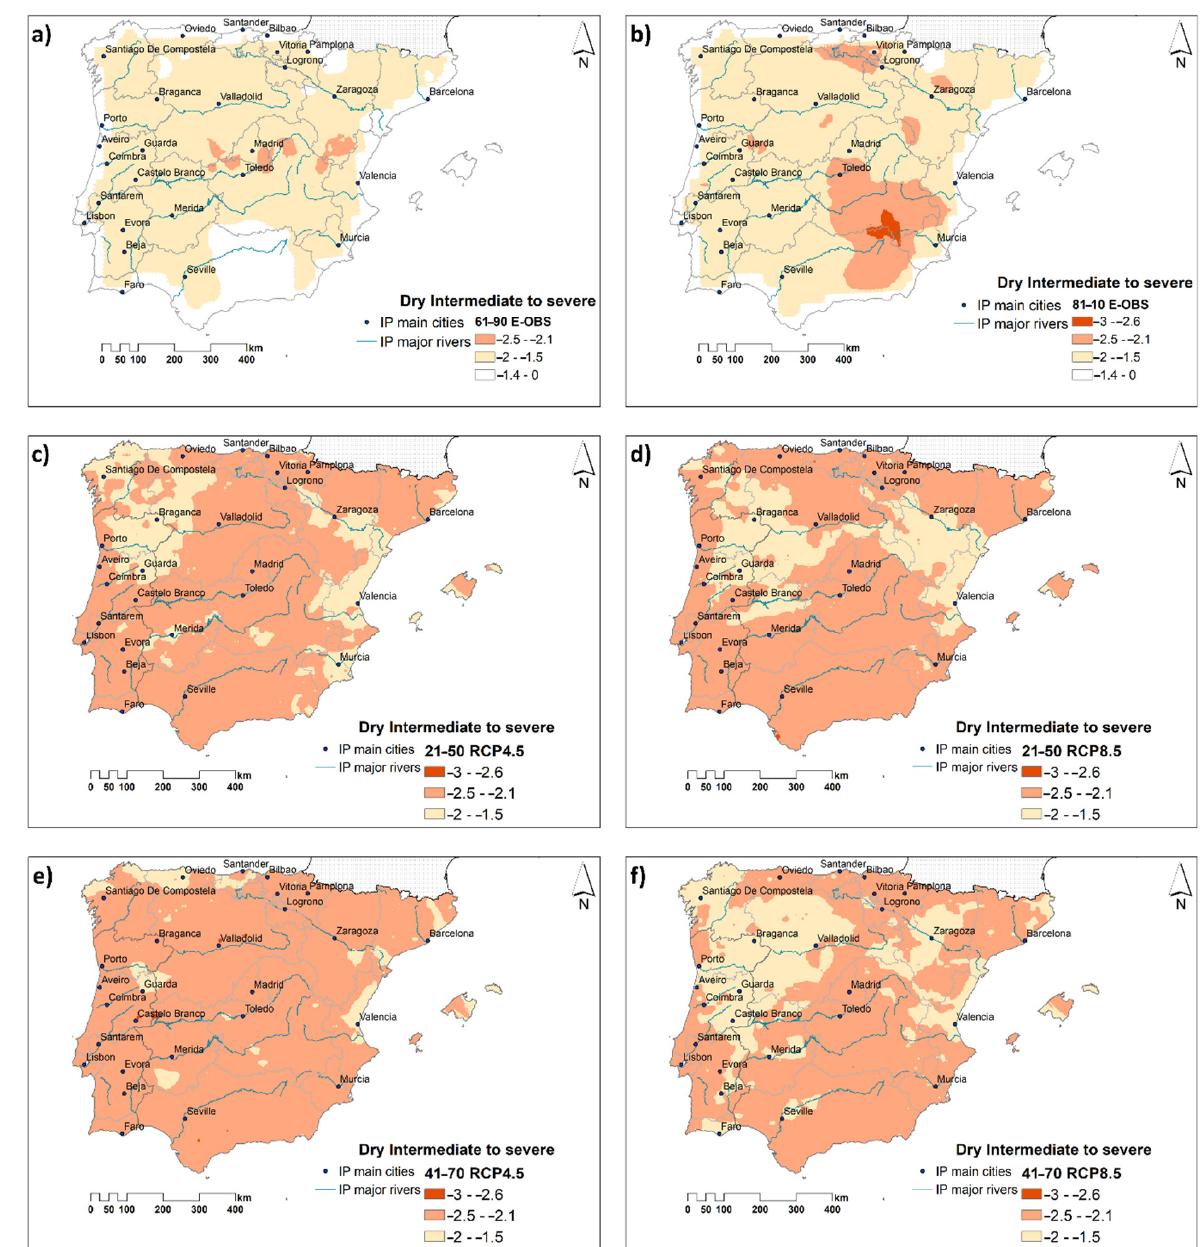
Figure 8. Intensity of 12m-WASP intermediate-to-severe dry events in IP for the periods ( a ) 1961–1990 and, ( b ) 1981–2010, ( c , d ) 2021–2050, ( e , f ) 2041–2070 under RCP4.5 (left) and RCP8.5 (right) (Note: NUTS 2 in grey contours).